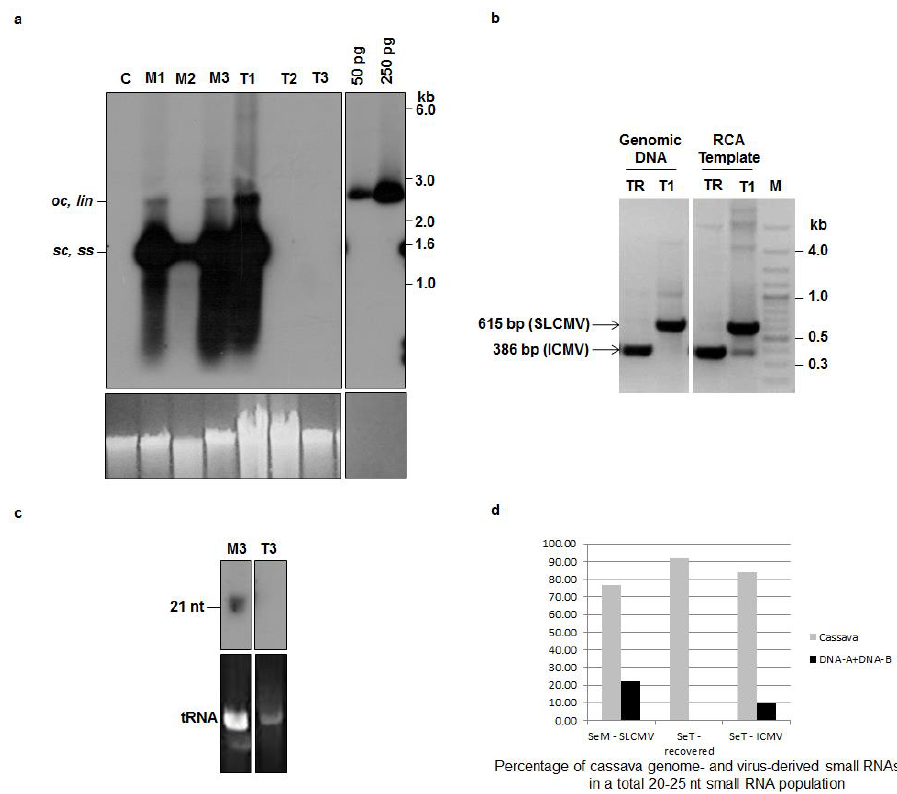
Figure 2. Sri Lankan cassava mosaic virus (SLCMV) DNA A and small interfering RNA (siRNA) analysis in symptomatic and symptom-recovered cassava plants. ( a ) Southern blot analysis of field-infected cassava plants maintained in the greenhouse. DNA (1 µ g) samples from a virus-free, axenic (tissue culture-grown) cassava plant (C), and field-infected cassava (cultivar Sengutchi) plants collected from Malappuram (M) and Thiruvananthapuram (T) were analyzed. The field-infected cassava plants were established in the Madurai Kamaraj University (MKU) greenhouse and the DNA was extracted during first year (M1 and T1), second year (M2 and T2) and third year (M3 and T3) of establishment in the greenhouse (Figure 1). pBS-SLCMV-Ma-A plasmid (50 pg and 250 pg) digested with PstI was used as a positive control. [ α - 32 P]dCTP-labeled full-length SLCMV-[SeM] DNA A was used as the probe. Positions of different forms of viral DNA, single stranded ( ss ), super-coiled ( sc ), open circular ( oc ) and linear ( lin ), are marked. Ethidium bromide stained high molecular weight plant DNA is shown as loading control at the bottom panel. ( b ) Diagnostic multiplex PCR using SLCMV- and ICMV-specific primers to analyze mixed infection in the plant sample T1 (field-infected SLCMV-SeT1, symptomatic plant) and TR (plant which initially recovered and subsequently showed re-emergence of CMD symptoms in the Basel greenhouse) (Figure 1). Genomic DNA and RCA-amplified DNA from T1 and TR were used as templates for polymerase chain reaction (PCR) analysis. Amplified fragments of SLCMV (615bp) and Indian cassava mosaic virus (ICMV) (386bp) are marked. M, Molecular weight marker. ( c ) Small RNA Northern blot analysis of field-infected cassava plants. RNA (10 µ g) from field-infected cassava plants collected from Malappuram (M3) and Thiruvananthapuram (T3) were analyzed. The field-infected cassava plants were established in the MKU greenhouse and RNA was extracted after 25 months of initial establishment in the greenhouse (M3 and T3). [ α - 32 P]dCTP-labeled SLCMV-[SeM] AC1 (1 kb) gene fragment was used as the probe. The position of siRNA (21 nt) is marked. The bottom panel shows ethidium bromide stained tRNA, as a loading control. ( d ) The proportion of the plant genome (cassava)- and the viral genome (DNA A + DNA B)-derived small RNAs in a total population of 20–25nt small RNAs accumulating in the Sengutchi cassava plants “SeM-SLCMV”, “SeT-recovered” and “SeT-ICMV” (Figure